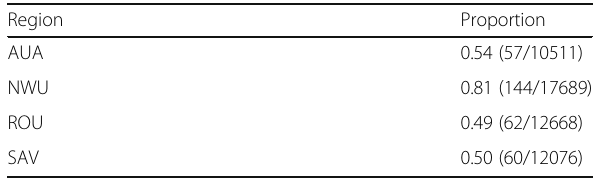
Table 2 Proportion of men > 18 years with hydrocoele cases by regions Region